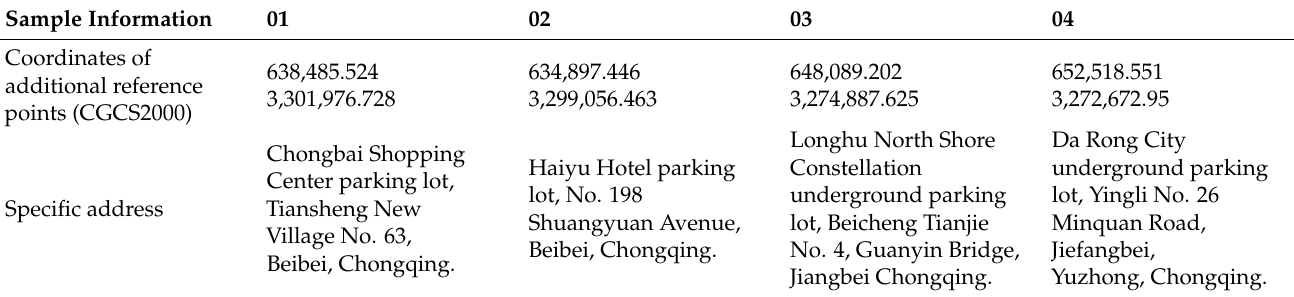
Table 5. Information on additional reference